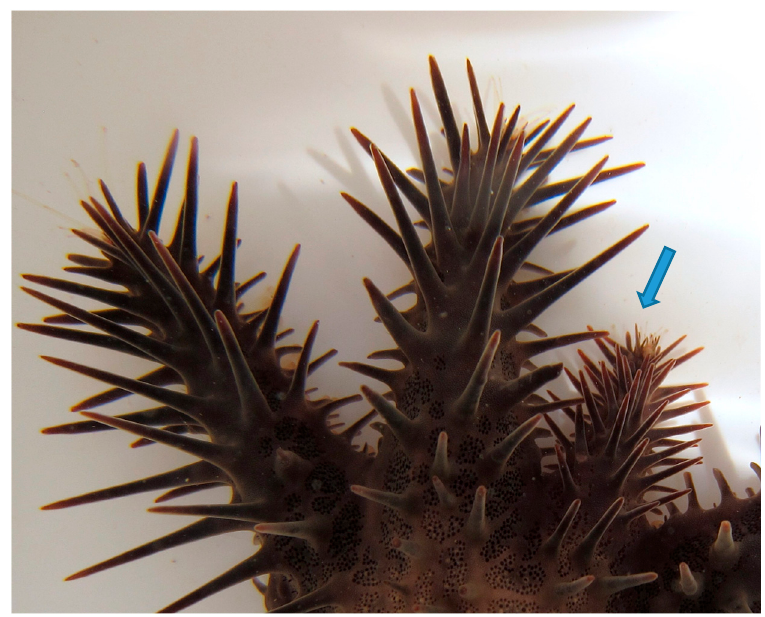
Figure 1. Small and regenerating arm of Acanthaster cf. solaris (as indicated by arrow), which is indicative of past injury, presumably caused by sub-lethal predation (see also [16]).